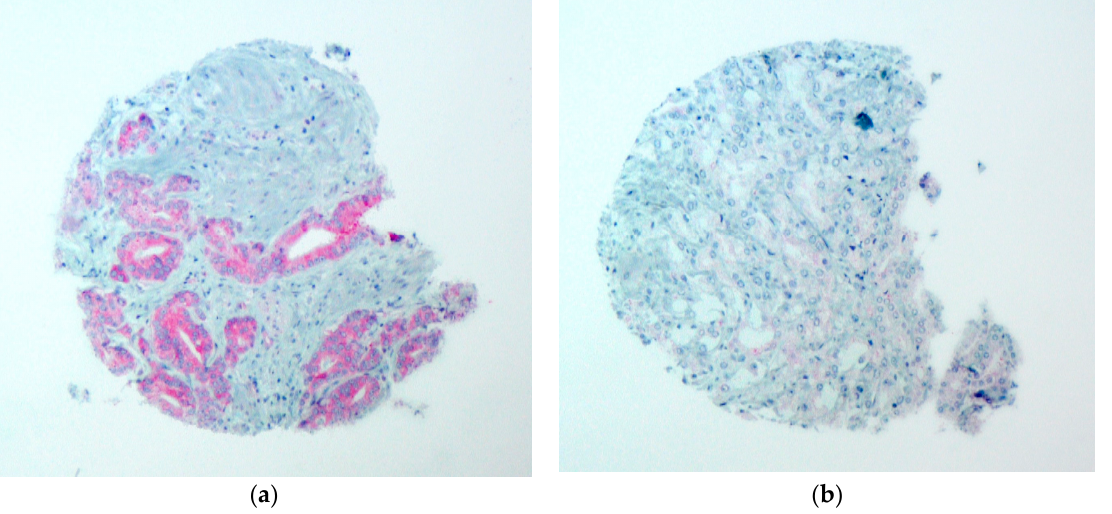
Figure 2. FAK shows cytoplasmic staining pattern; ( a ) tumor cells with high FAK expression; ( b ) tumor cells with low FAK expression with a magnification of 100×.